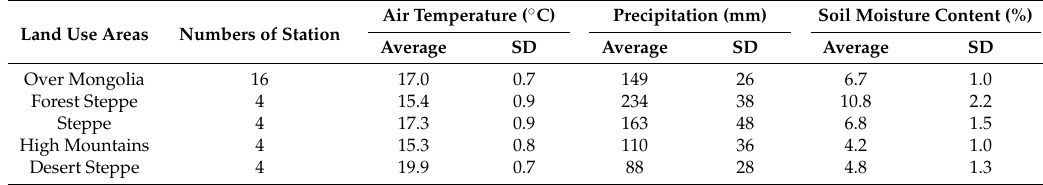
Table 2. Average and standard deviations (SD) of air temperature ( ˝ C), precipitation (mm) and soil moisture content (%) over the sixteen stations divided into four various land use areas (forest steppe, steppe, high mountains and desert steppe) for the 2000–2013 growing seasons.